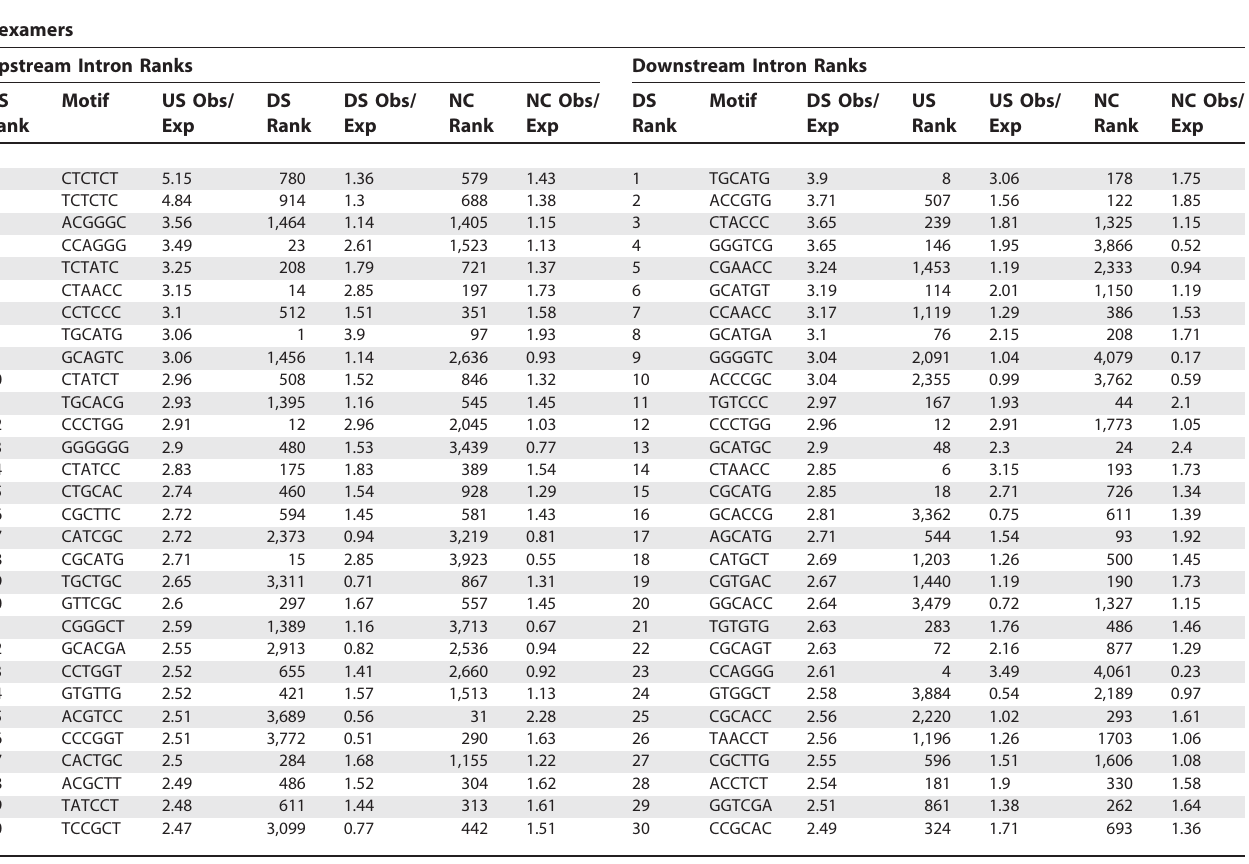
Table 4. Comparison of the Occurrence of Hexamer Motifs in Introns Upstream versus Downstream of Alternative Cassette Exons Hexamers Upstream Intron Ranks Downstream Intron